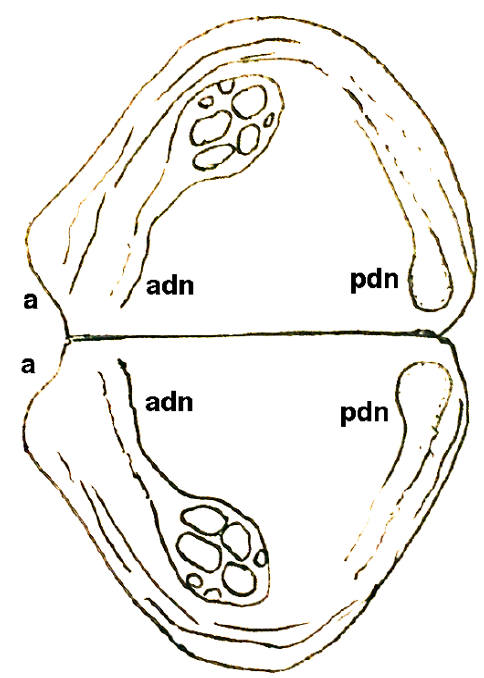
Figure 15. Hipponicharion loculatum . Paired shields shown in butterfly position. Anterior to left. Length of shield 1.5 mm. Abbreviations: a, anterodorsal cardinal marginal concavity; adn , anterodorsal node; pdn , posterodorsal node. Image Credit: Mark McMenamin.